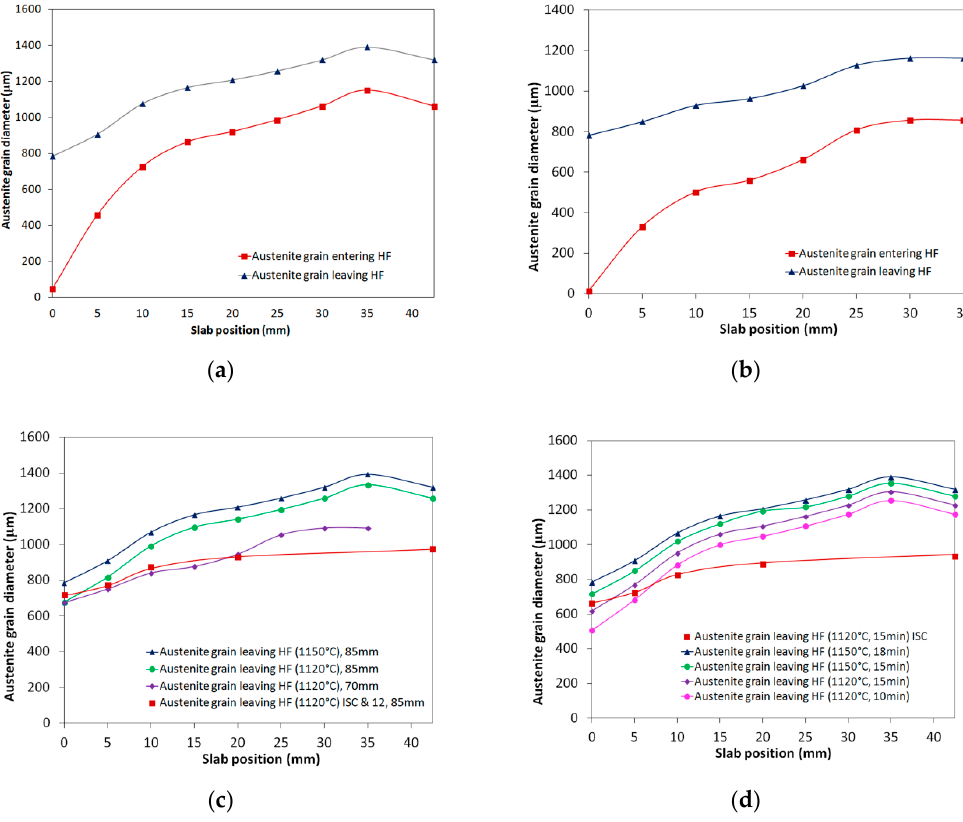
Figure 13. ( a ) Comparison of DSPC 85-mm thick slab austenite grain size before entering and after leaving the holding furnace (1150 °C, 18 min); ( b ) comparison of DSPC 70-mm thick slab austenite grain size before entering and after leaving the holding furnace (1150 °C, 18 min); ( c ) the effect of holding temperature 1120 and 1150 °C on austenite size after leaving the holding furnace; and ( d ) the effect of holding time and temperature on austenite grain size after leaving the holding furnace.